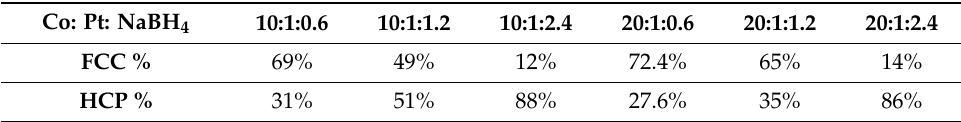
Table 1. Conversion of the cobalt structure from the FCC phase to the HCP phase at different composition ratios.